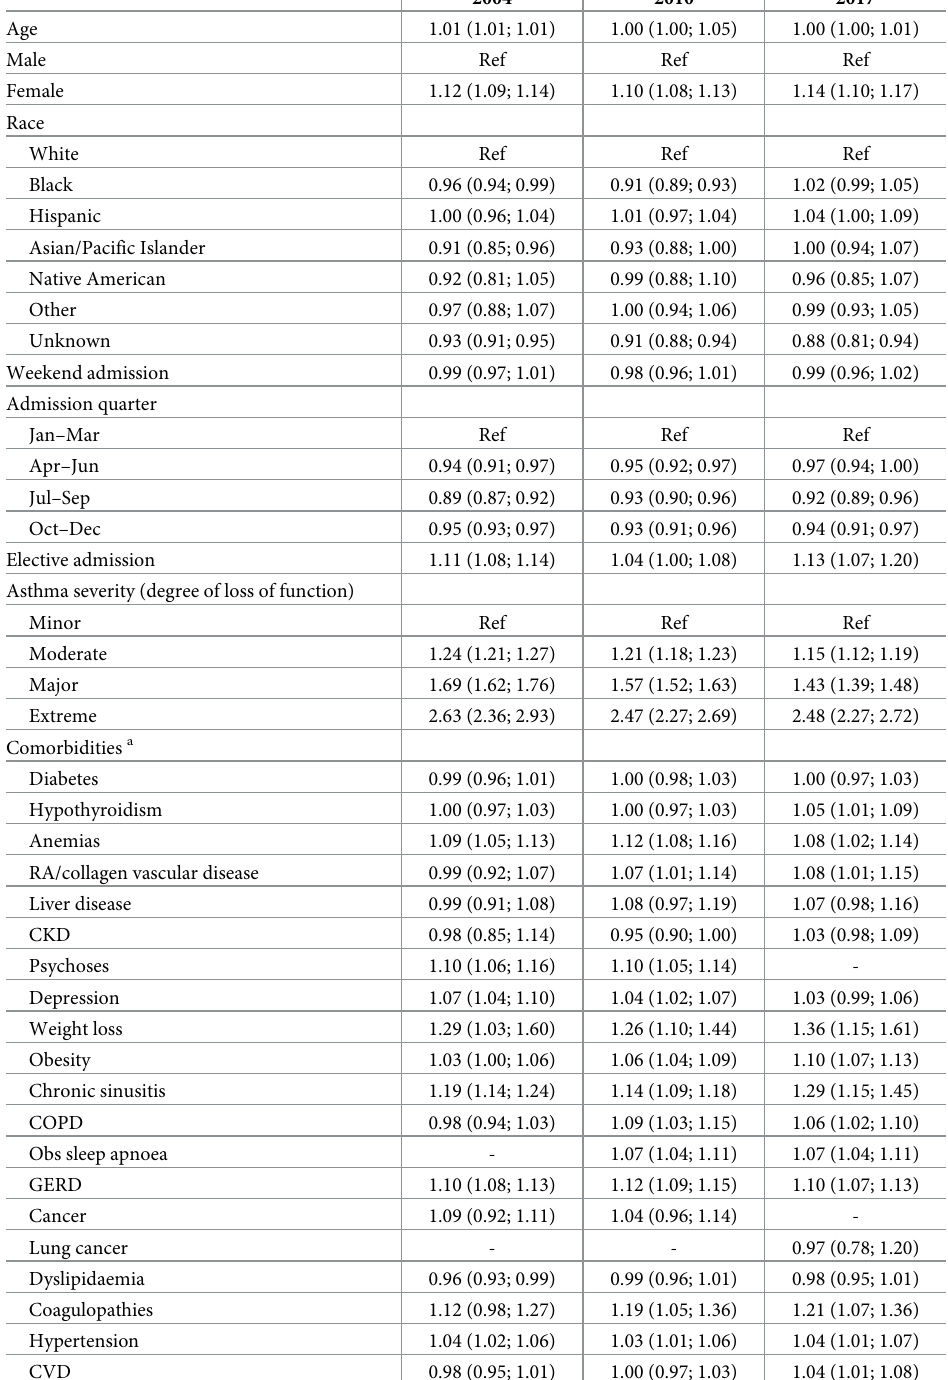
Table 2. Incidence rate ratios (95% CI) for length of hospital stay (days) in adult patients (18+ years) admitted with asthma in 2004, 2010 and